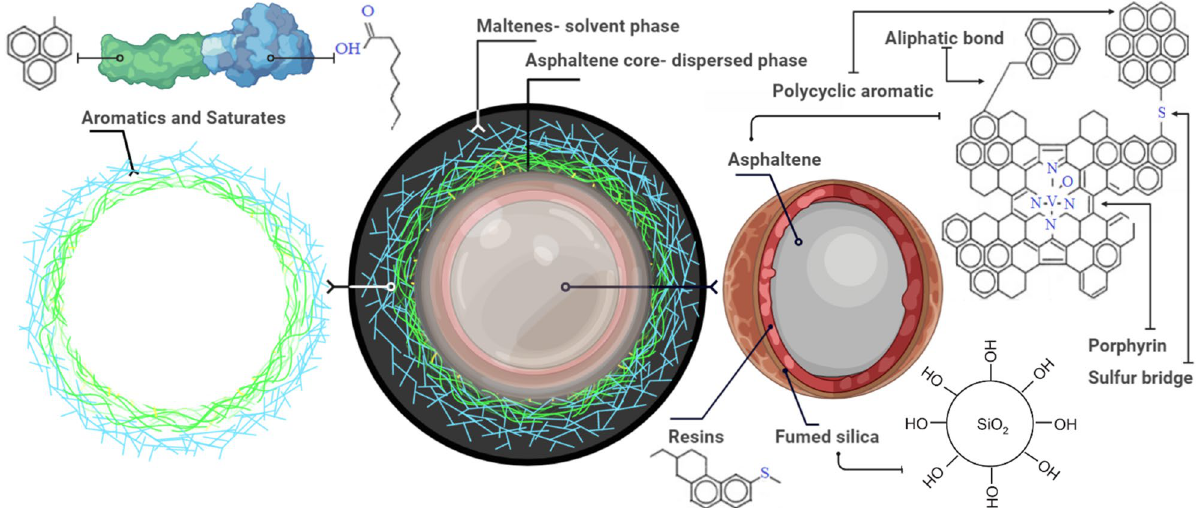
Figure 11. Schematic representation of the FSN action in the colloidal structure of